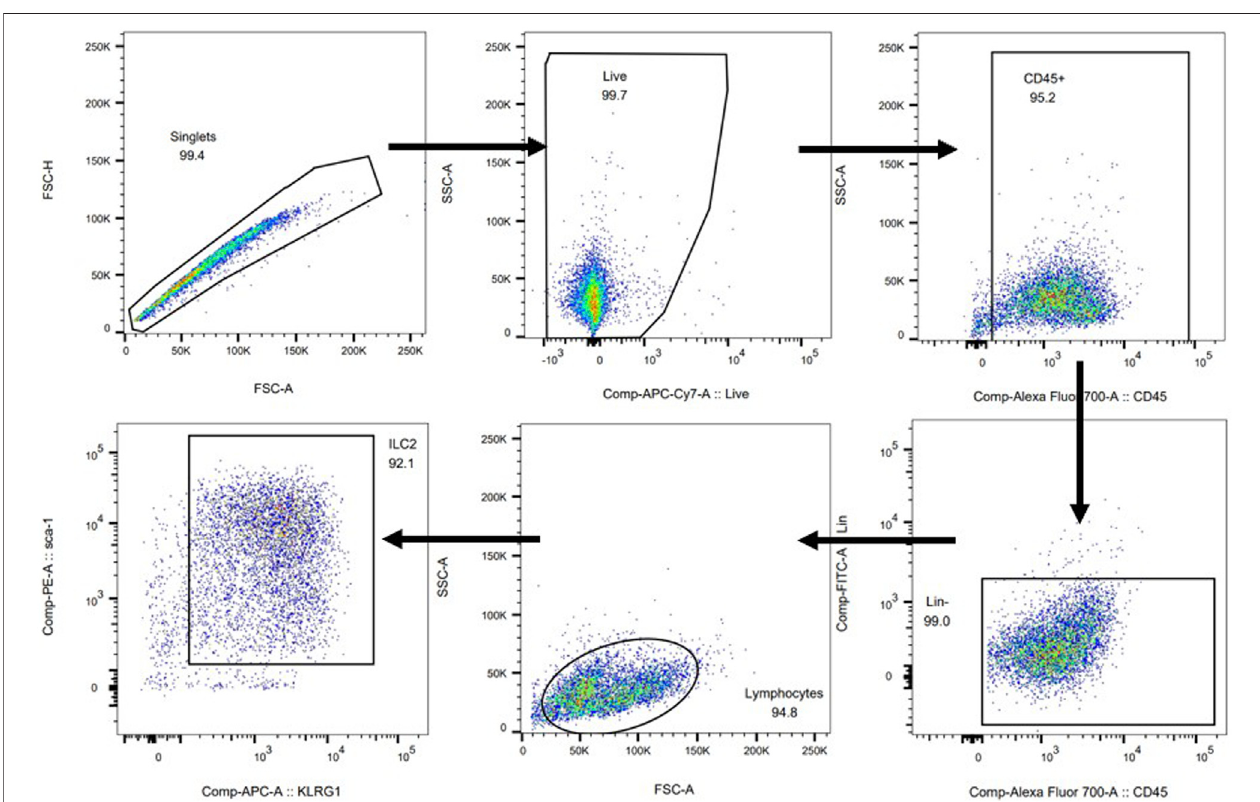
FIGURE 6 | Cell sorting protocol and purity of